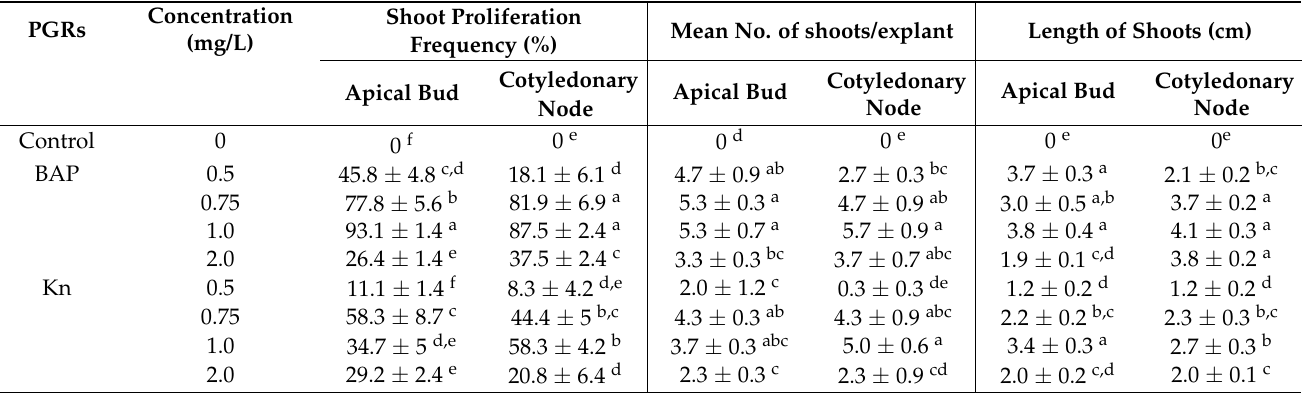
Table 4. Effect of BAP and Kn on direct shoot regeneration in D. purpurea .